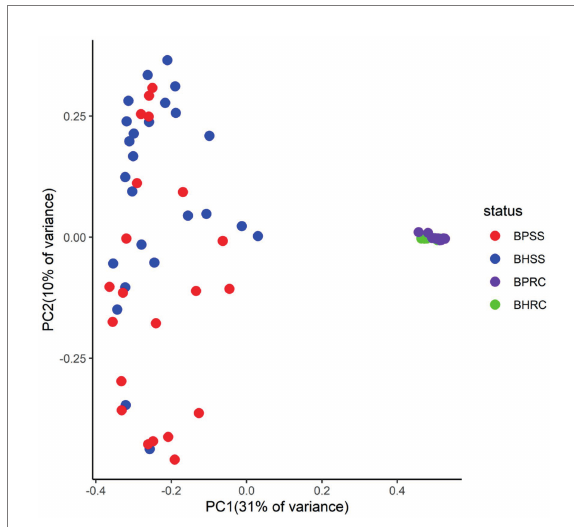
FIGURE 4 Two-dimensional ordination of bovine microbial profiles in oral health (BHSS) and periodontitis (BPSS) and in the ruminal fluid of animals with periodontitis (BPRC) and orally healthy animals (BHRC) by principal coordinate analysis